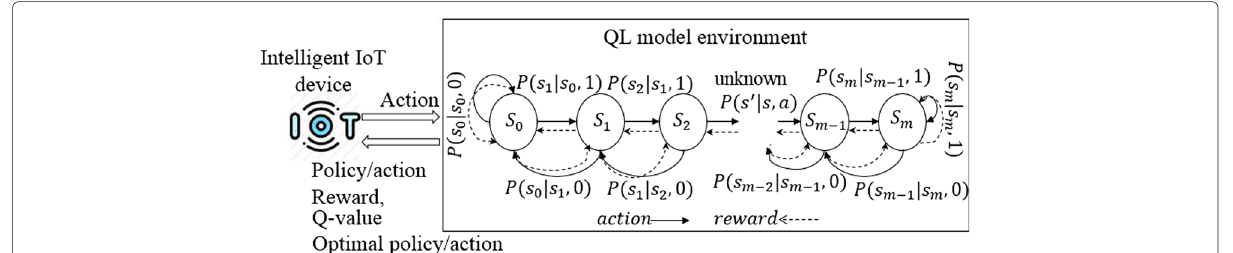
Fig. 5 QL model environment with its elements in the case study of DCF-based backoff